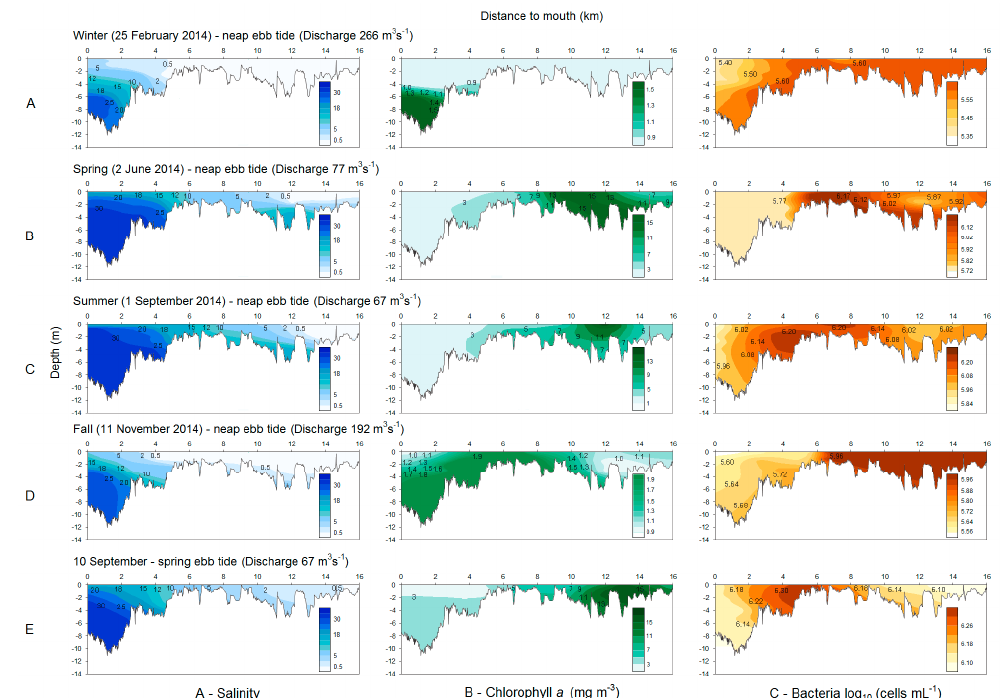
Figure 3. Longitudinal profile of salinity, chlorophyll a (mg m − 3 ), and bacteria (log 10 cells mL − 1 ) during seasonal neap tide ( A – D ) and the spring tide ( E ) surveys.